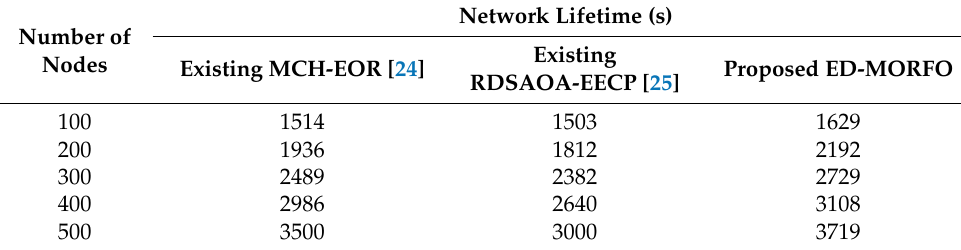
Table 6. Performances of end-to-end delay.